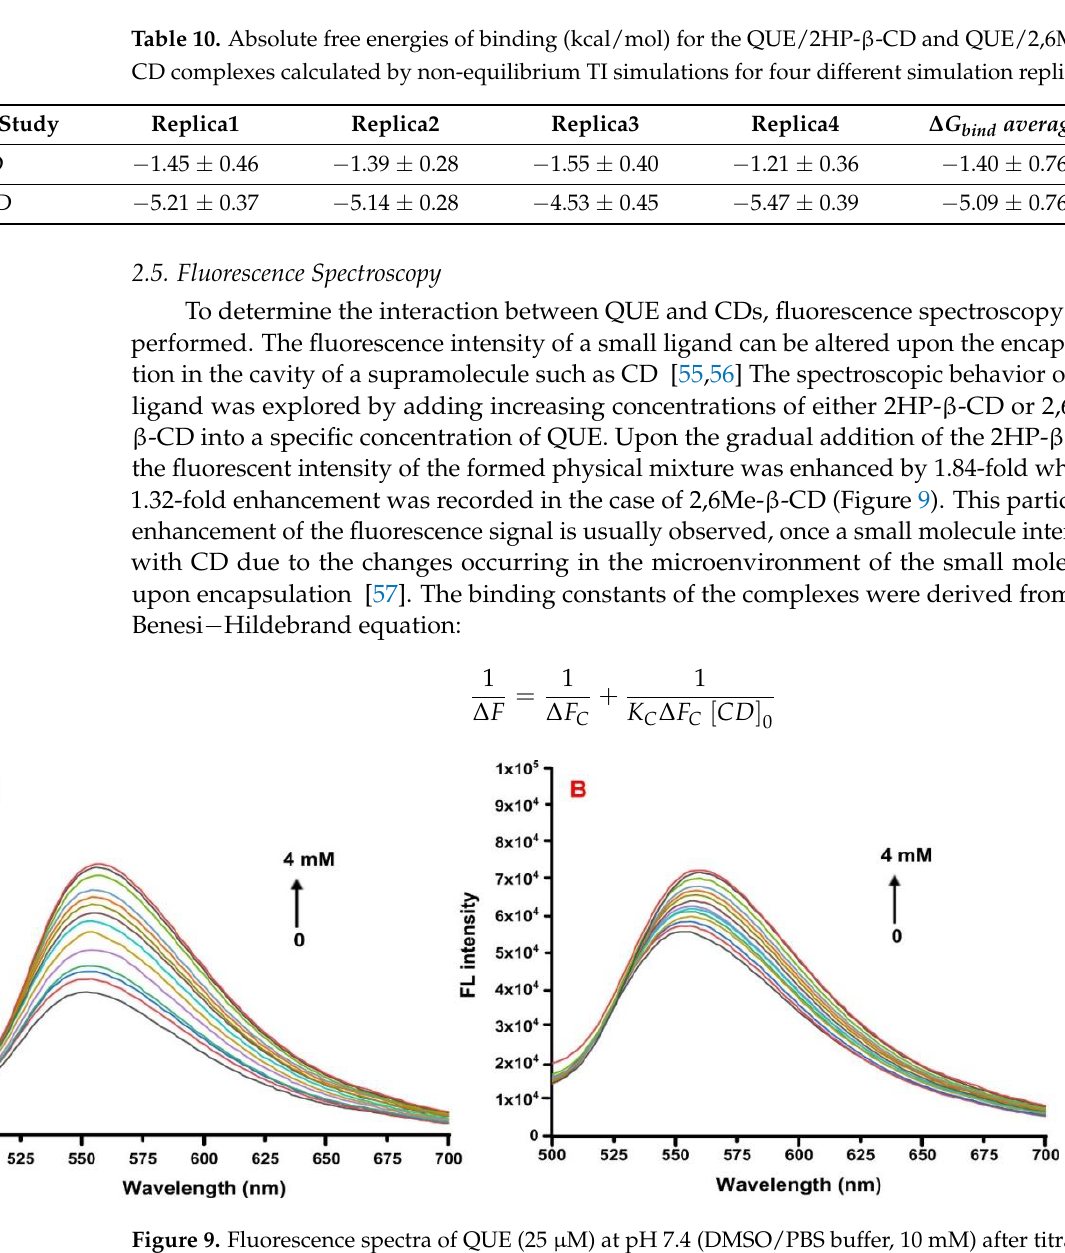
Figure 10. Double-reciprocal plots of the QUE titration with various concentrations of CDs (0, 0.1, 0.2, 0.3, 0.4, 0.5, 0.6, 0.7, 0.8, 0.9, 1.0, 2.0, 3.0 and 4.0) ( A ) 2HP- β -CD and ( B ) 2,6Me- β -CD.